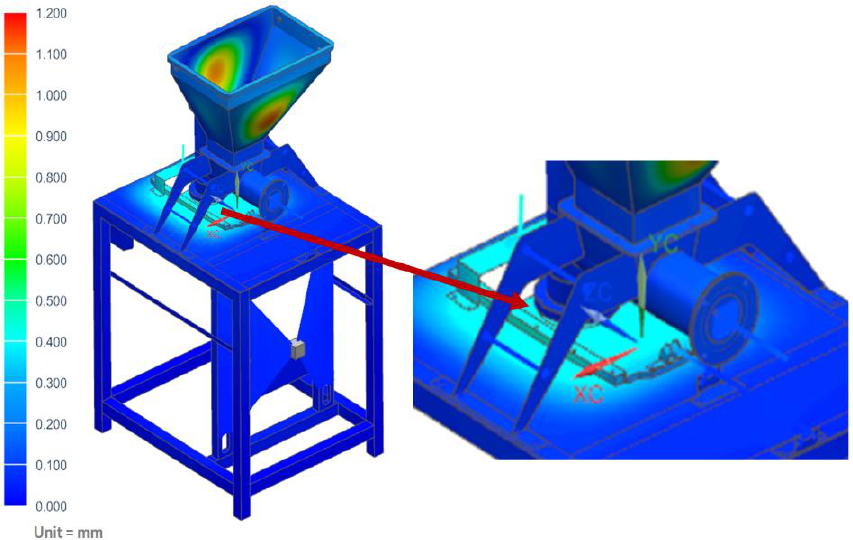
Figure 18. Displacement map of the molding module: die assembly is locked in the runners.